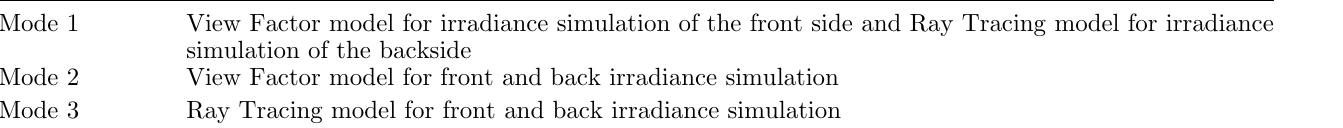
Table 1. All the simulation modes for the irradiance simulation of the bifacial PV plant. Mode 1 View Factor model for irradiance simulation of the front side and Ray Tracing model for irradiance simulation of the backside Ray Tracing model for front and back irradiance